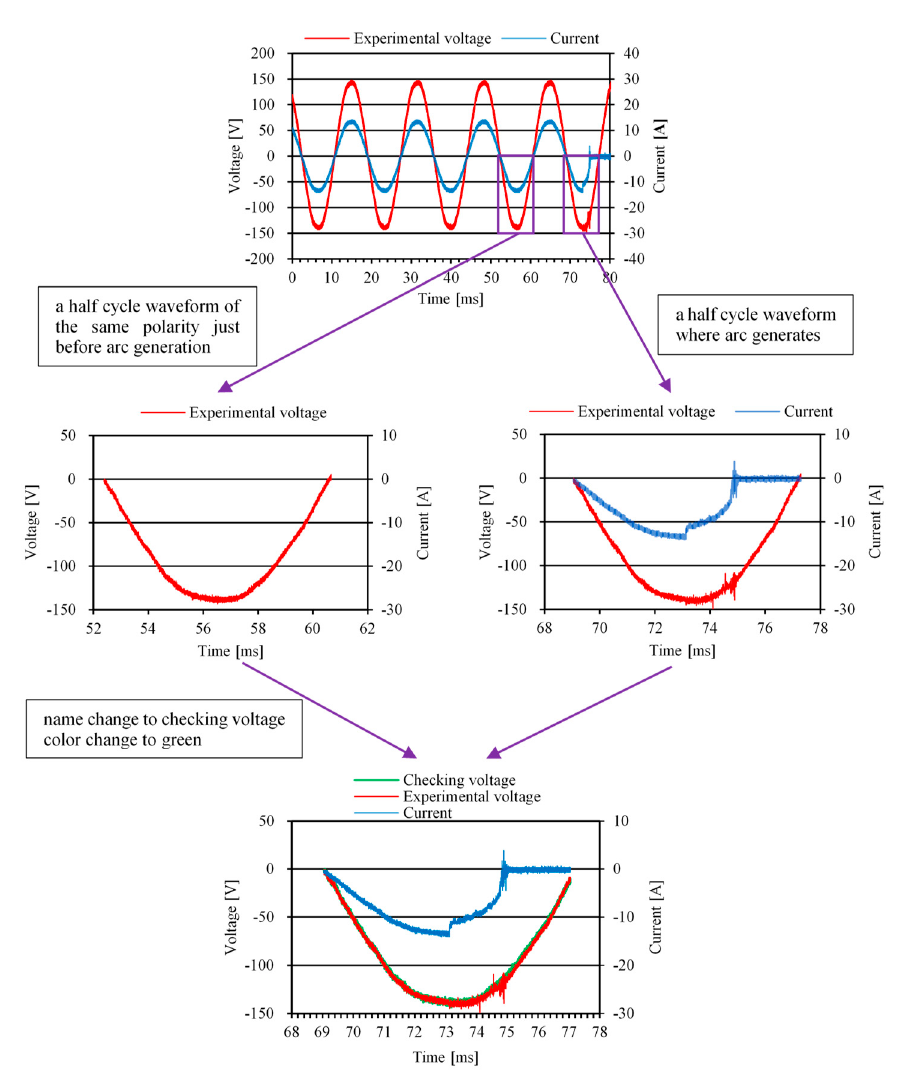
Figure 14. Procedures to obtain checking voltage.